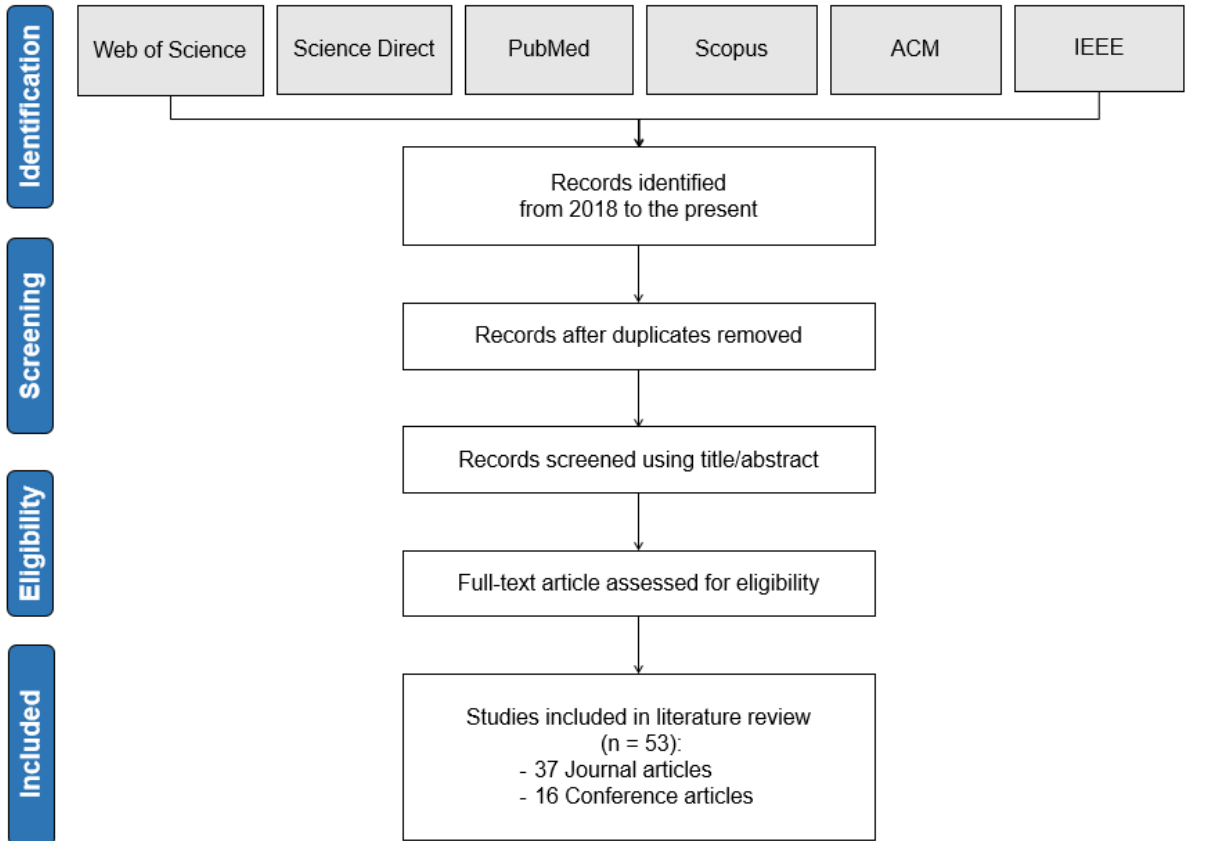
Figure 3. The process of literature selection used in this study.